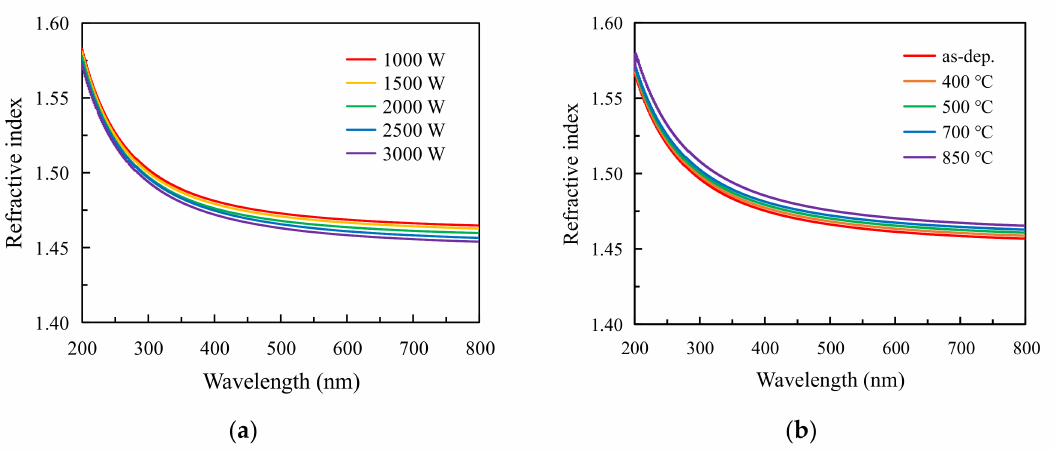
Figure 4. Refractive index spectra for the RP-ALD SiO 2 thin films ( a ) with various plasma powers; ( b ) with and without different annealing